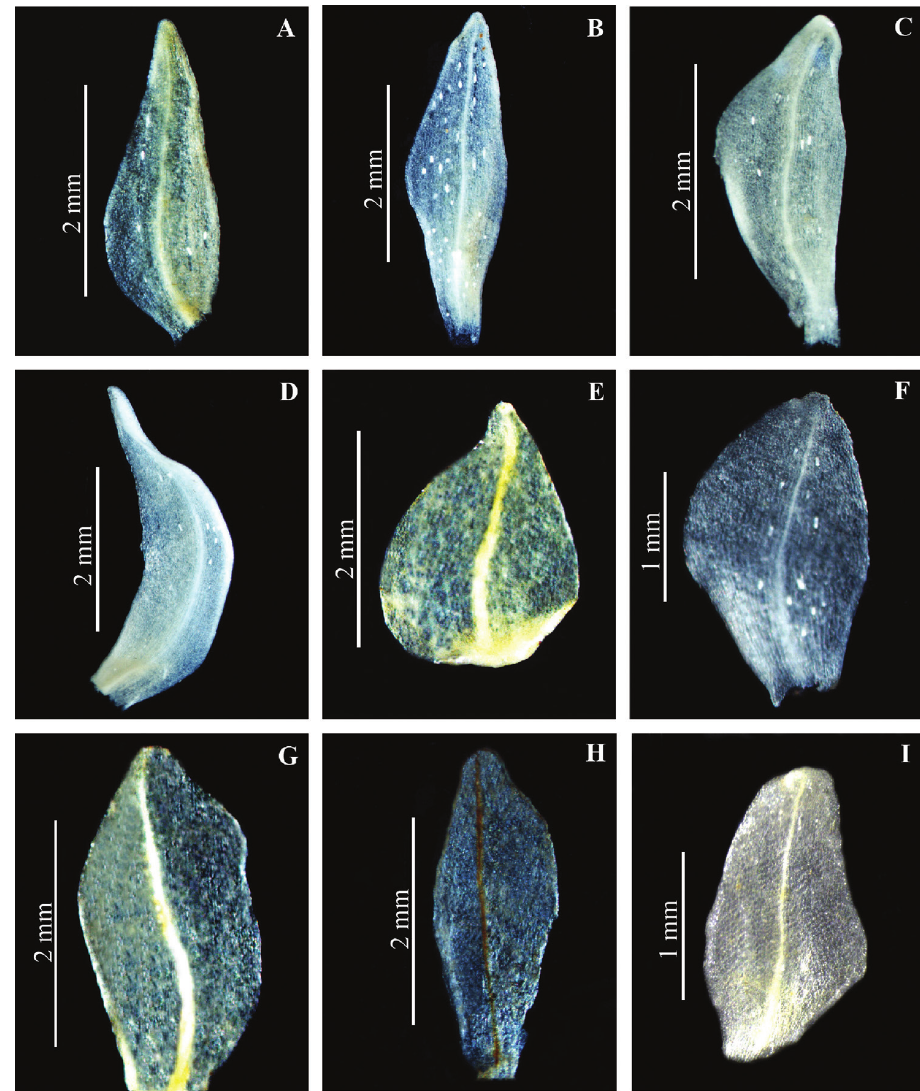
Figure 7. Lateral sepal of Herminium . A H. monorchis B H. chloranthum C H. pygmaeum D H. josephi E H. monophyllum F H. lanceum G H. macrophyllum H H. glossophyllum I H. coeloceras.